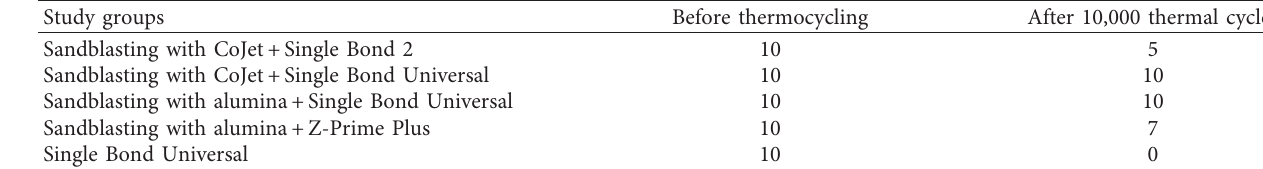
Table 1: Number of specimens before and after thermocycling.